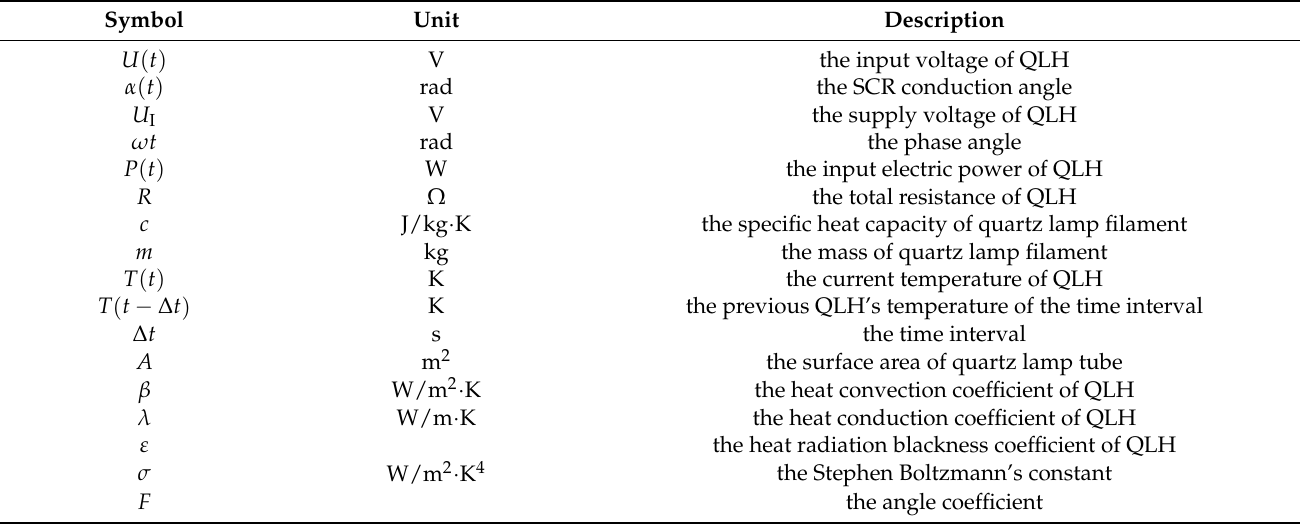
Table 6. All parameters of